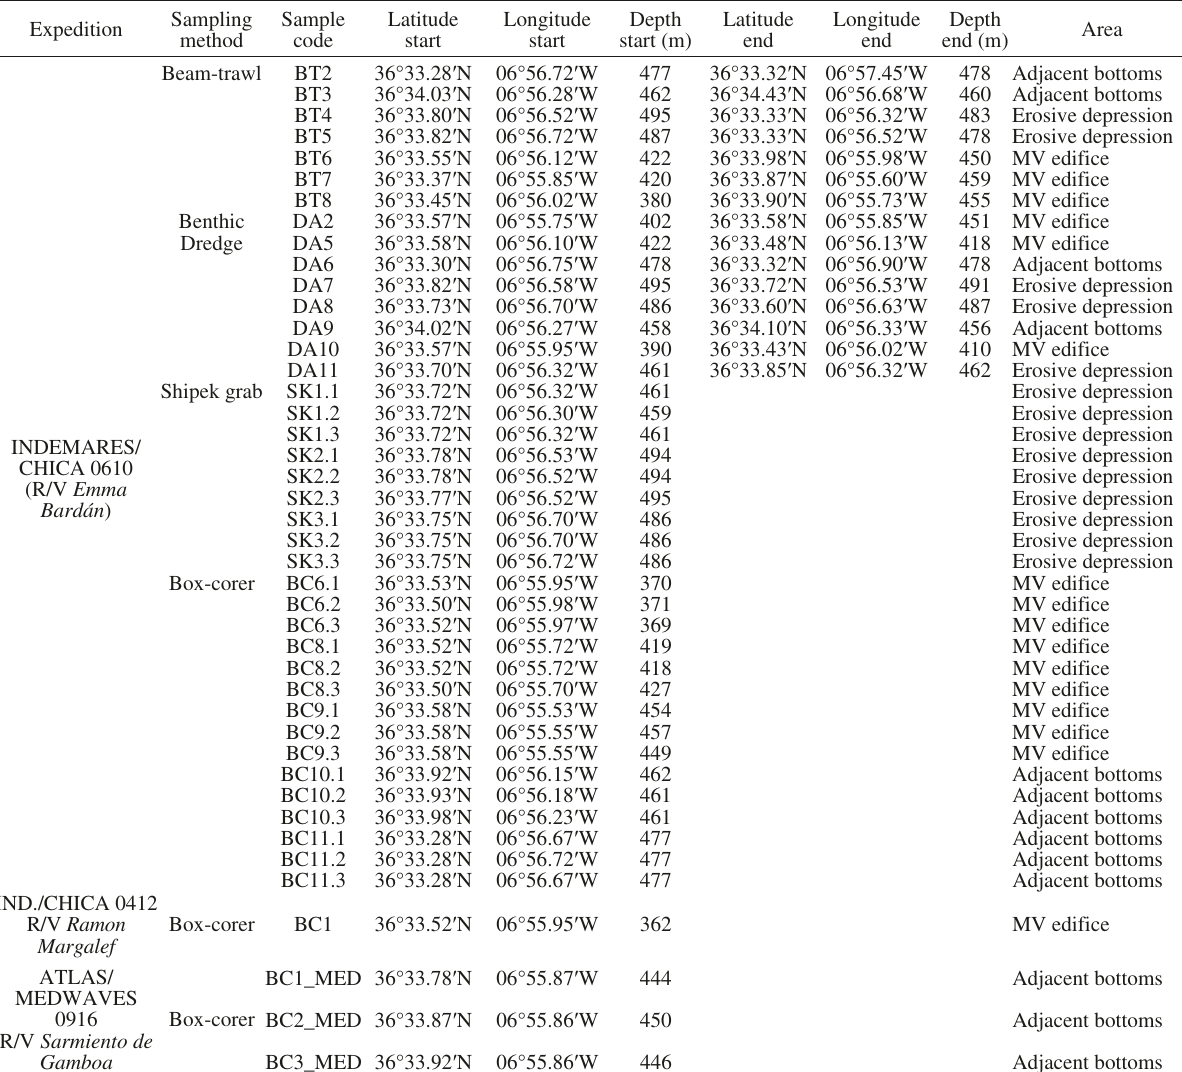
Table 1. – Location and details of sampling stations on the oceanographic expeditions on the Gazul mud volcano (MV) (northern Gulf of Cádiz). BT, beam-trawl; DA, benthic dredge; SK, Shipek grab; BC, box-corer. For the SK and BC, the first digit is the sample number and the second digit refers to